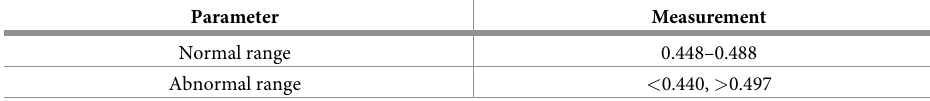
Table 1. Normal and abnormal range of CLR ratio